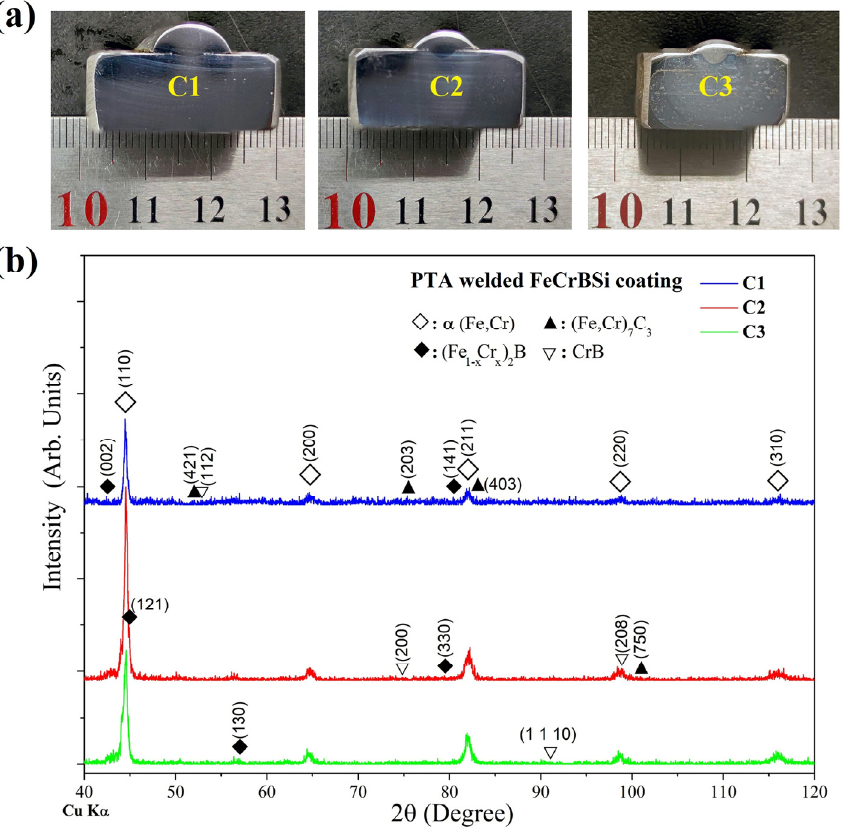
Figure 5. ( a ) Overall cross-section photographs at a low magni fi cation and ( b ) XRD pa tt erns of the PTA-welded